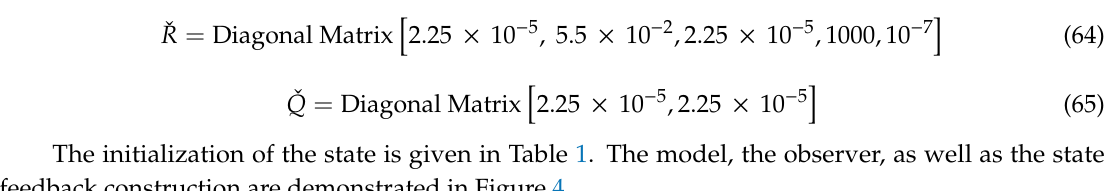
Table 1. Initialization second order extended Kalman filter (SEKF).